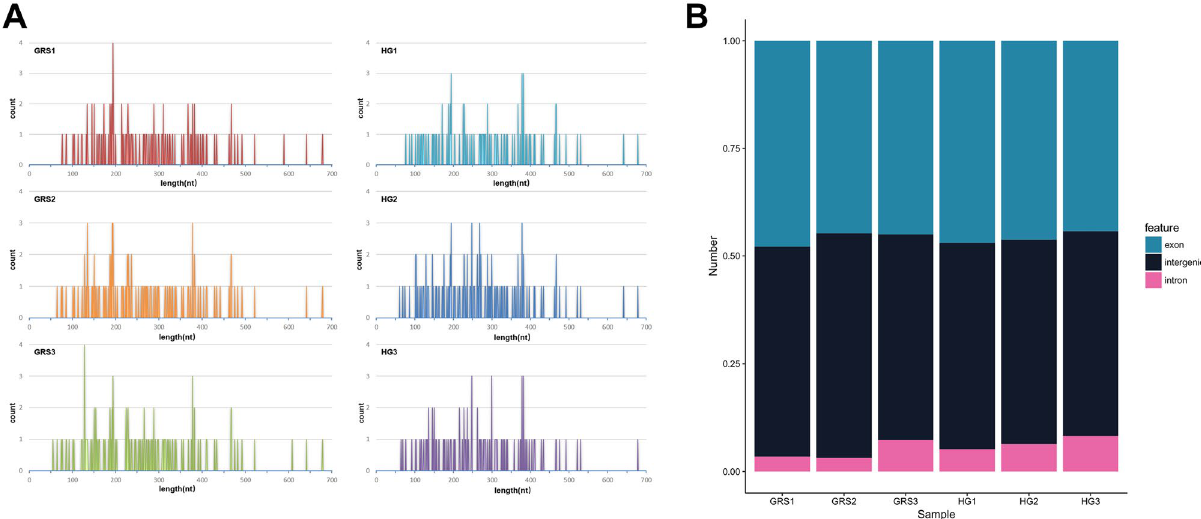
Figure 2. Identification results and characteristics of circRNA. ( A ) Length distribution of circRNAs; ( B ) circRNAs classification. Image generated with Microsoft Office Excel and R 3.6.3 (https:// www.R- proje ct. org) 51 ggplot2 package (https:// ggplo t2. tidyv erse. org).